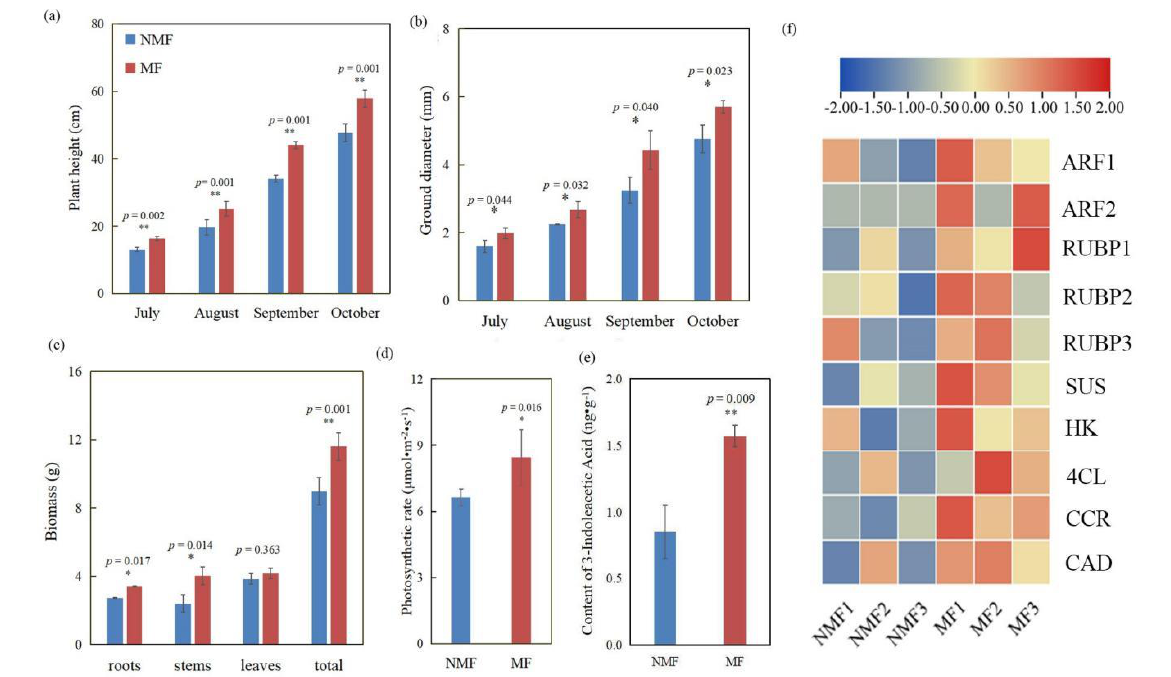
Figure 2. Influence of mycorrhizal fungal colonization on height and ground diameter growth, biomass accumulation, endogenous 3 − indoleacetic acid, net photosynthetic rate, and expression of growth − related genes in C. paliurus . ( a , b ) Changes in plant height and ground diameter after inoculation with mycorrhizal fungi from July to October; ( c ) biomass accumulation in different organs; ( d , e ) changes in 3 − indoleacetic acid level and net photosynthetic rate in mycorrhizal seedlings or non − mycorrhizal seedlings; ( f ) clustering heat map of the differentially expressed genes (DGEs) in growth − related pathway after inoculation with mycorrhizal fungi. ARF, auxin response factor; RUBP, ribulose − 1,5 − bisphosphate carboxylase/oxygenase; SUS, sucrose synthase; HK, hexokinase; 4CL, 4 − coumarate-CoA ligase; CCR, cinnamoyl − CoA reductase; CAD, cinnamyl alcohol dehydrogenase. * p < 0.05 and ** p < 0.01 indicate significant differences between inoculation and non-inoculation in two-tailed Student’s tests. The color in the heat map represents the corresponding FPKM value of genes.